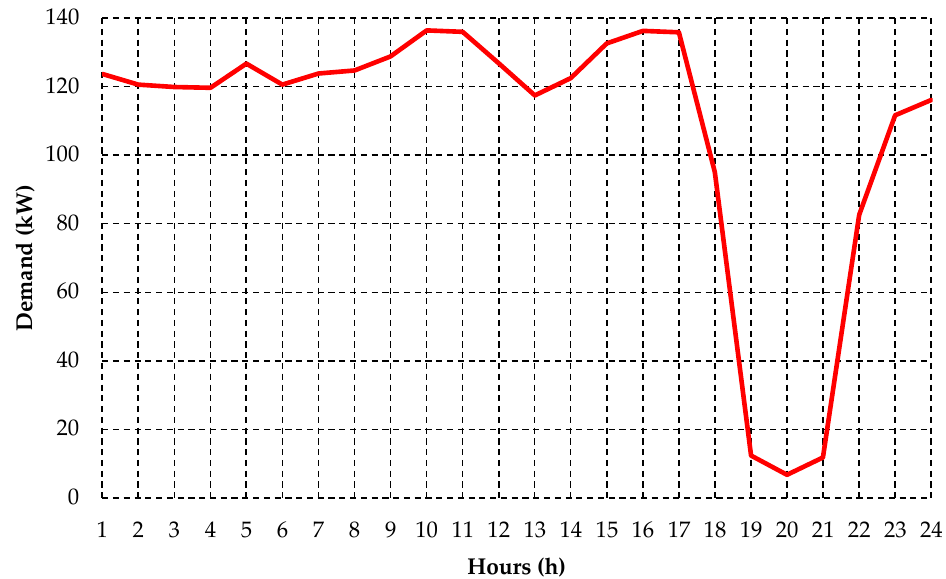
Figure A1. Daily demand profile of an irrigator customer. Source: The authors.